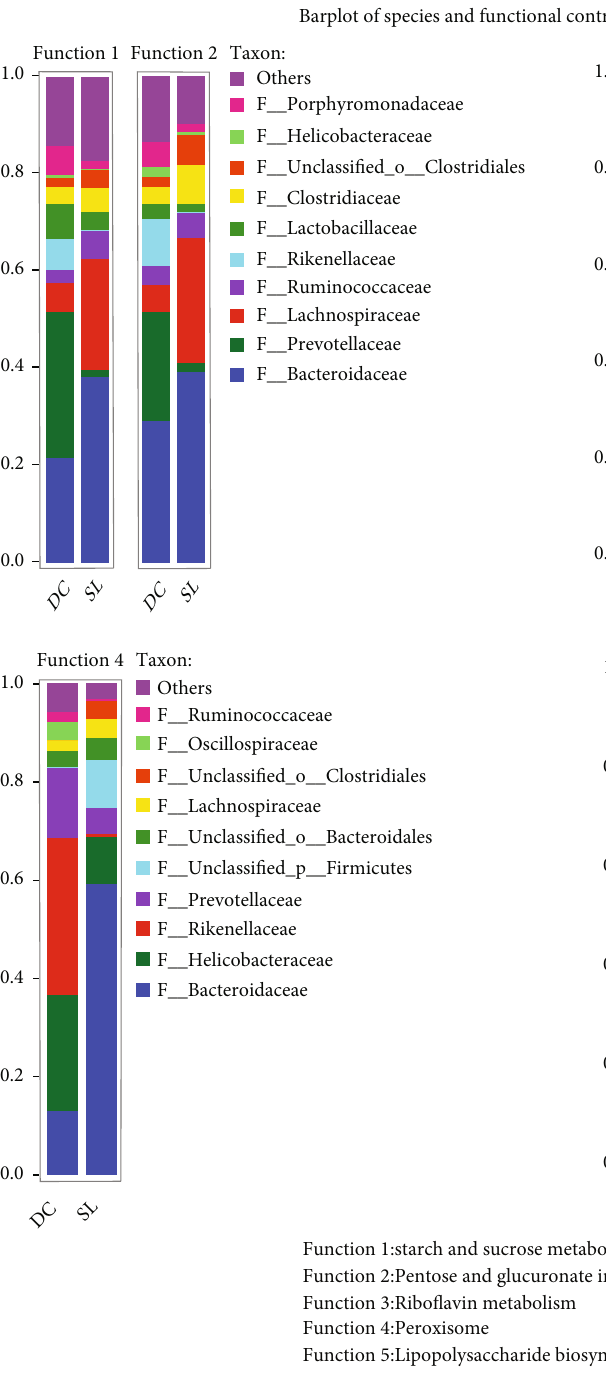
Figure 7: Barplot of species and functional contribution analysis indicates the dominant species composition of a particular